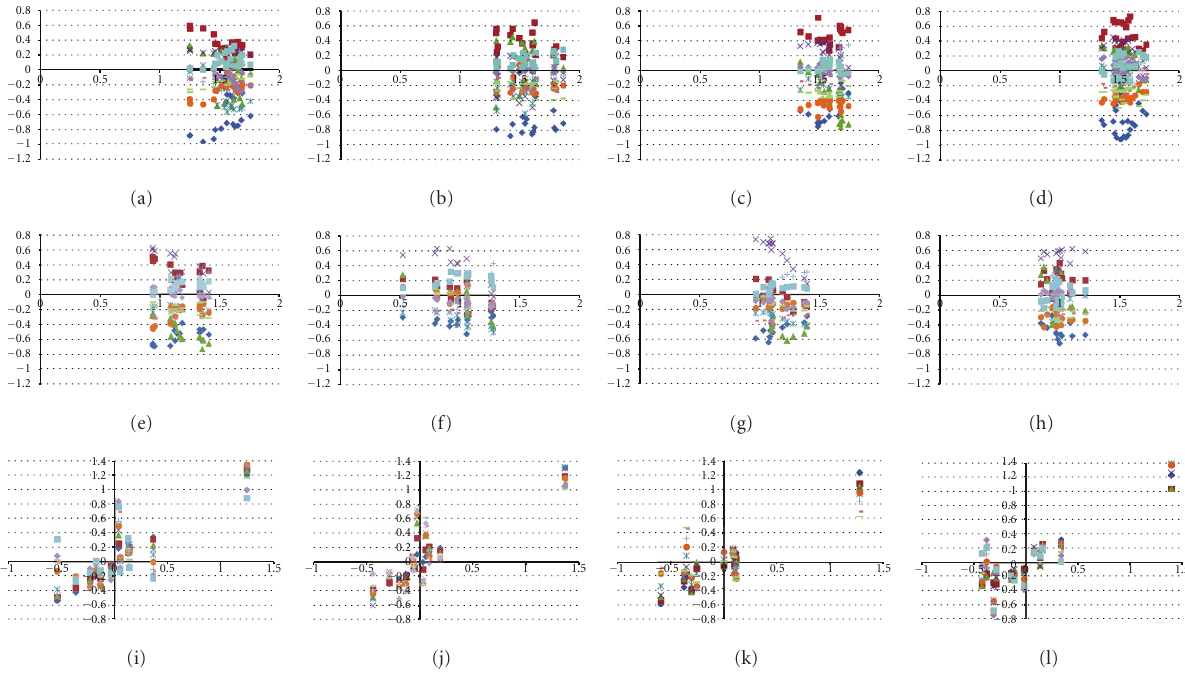
Figure 5: Visualization of time series plots that represent the voiceprints by three di ff erent speakers who uttered the same Japanese vowels.